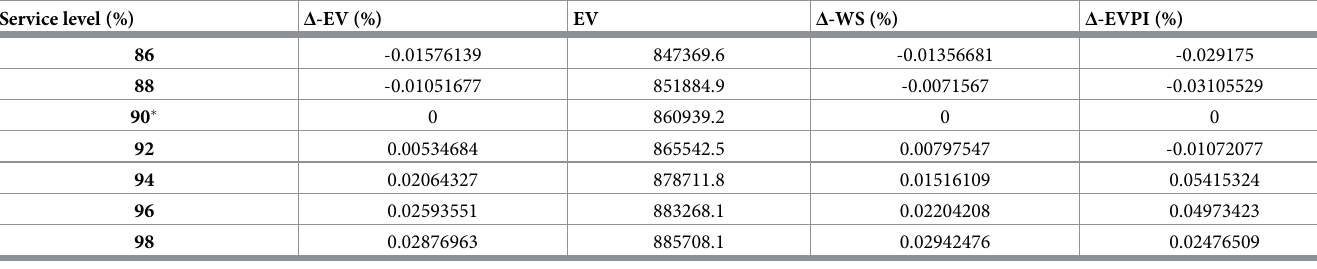
Table 11. Impact of the service level constraint in Model-II. Own elaboration. Service level